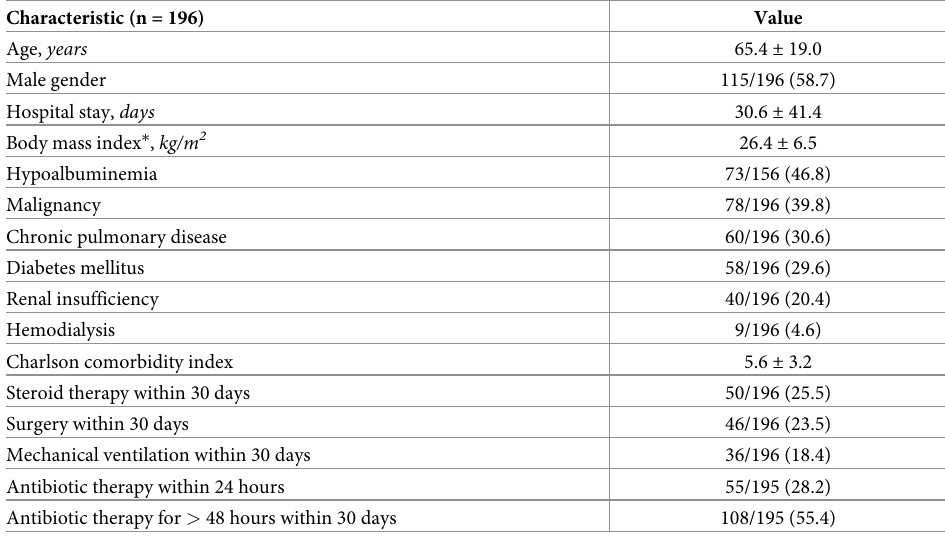
Table 1. Demographic characteristics of patients with Pseudomonas aeruginosa infections.